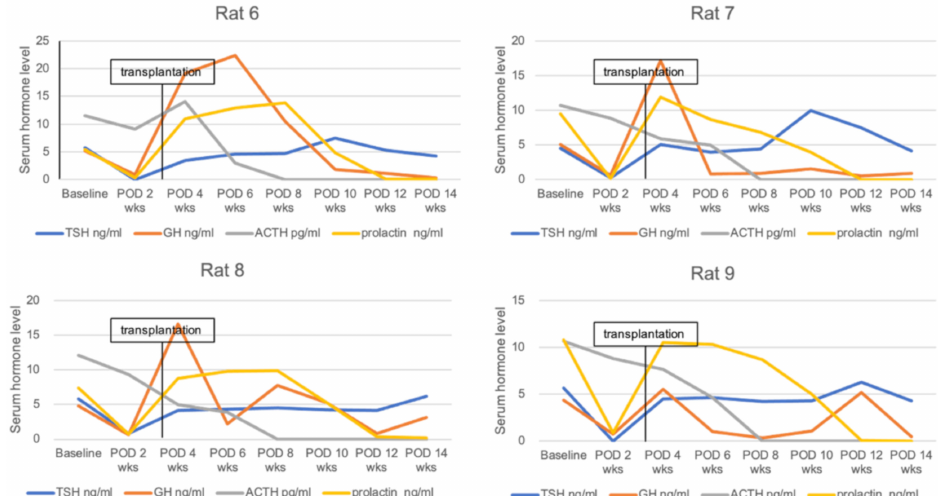
Figure 5. Serum hormone changes of four rats after hypophysectomy and pituitary transplantation. The serum TSH level was elevated up to the baseline level at post-transplantation 1 week and maintained until 11 weeks after trans- plantation. Serum GH and prolactin levels normalized at 1 week after transplantation but decreased over time. Serum ACTH level gradually decreased after hypophysectomy and was not detected at 14 weeks post-hypophysectomy. POD, postoperative day.